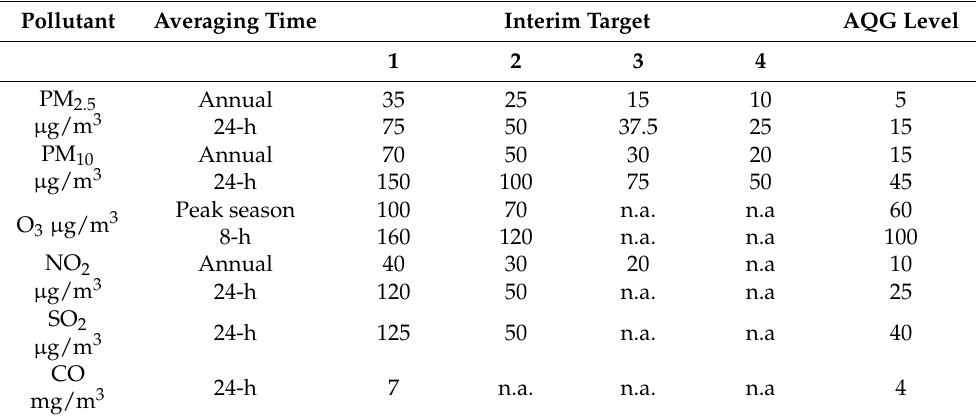
Table 2. Recommended air quality guidelines (AQG) levels and interim